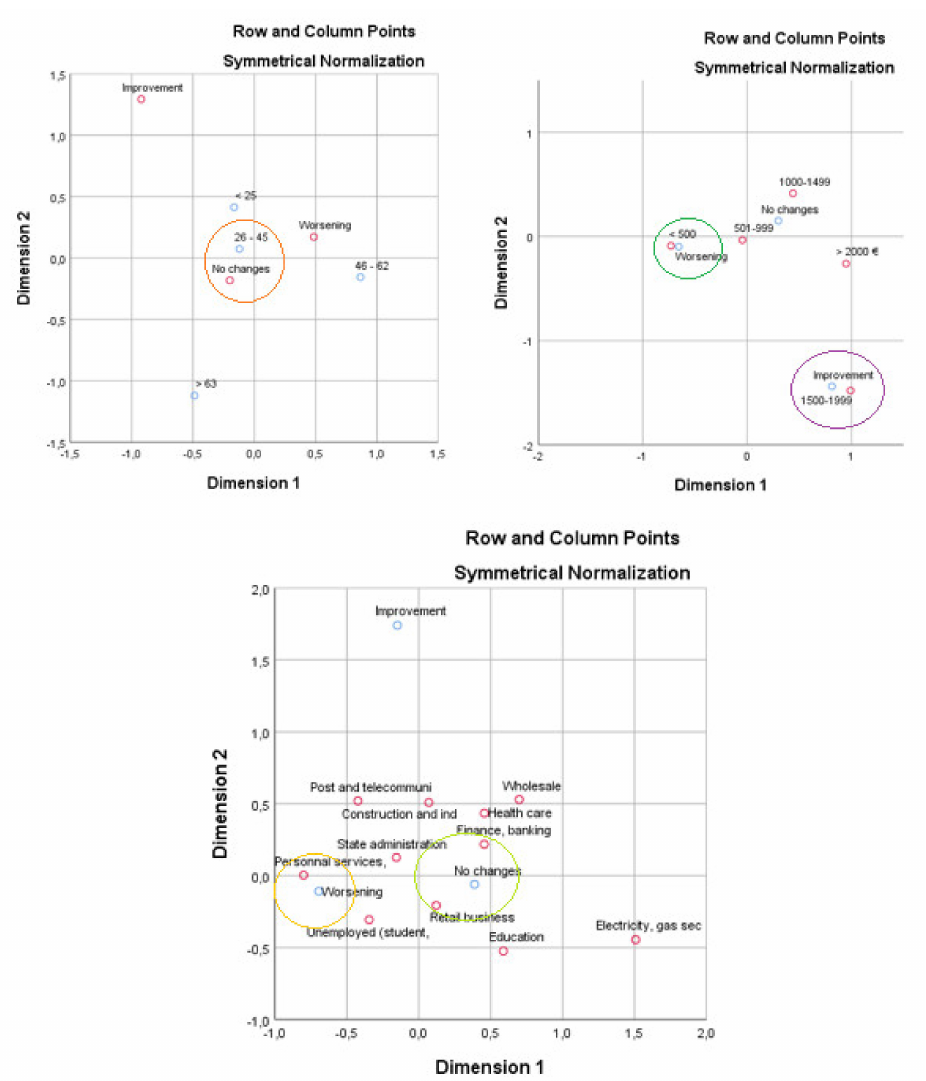
Figure 1. Individual correspondence maps between analyzed